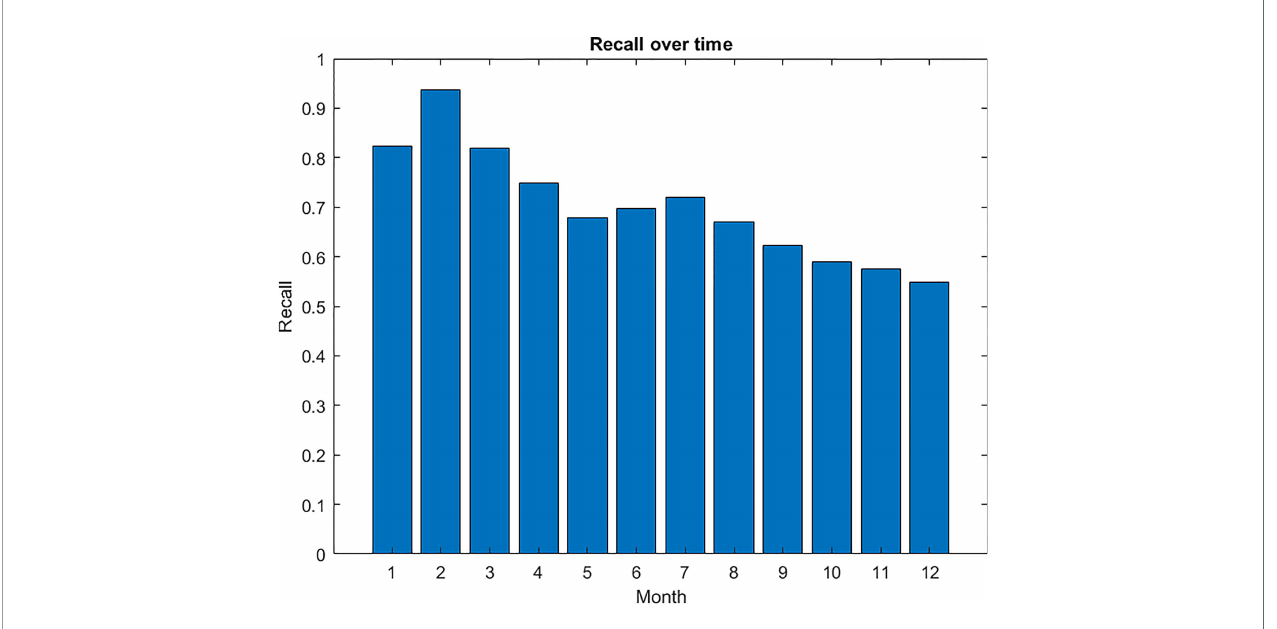
FIGURE 7 | Monthly averaged recall for fi sh detection with the progressive decreasing trend.